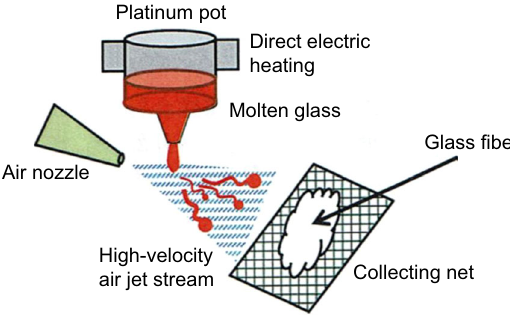
Fig. 2 Schematic representation of preparation of glass fi